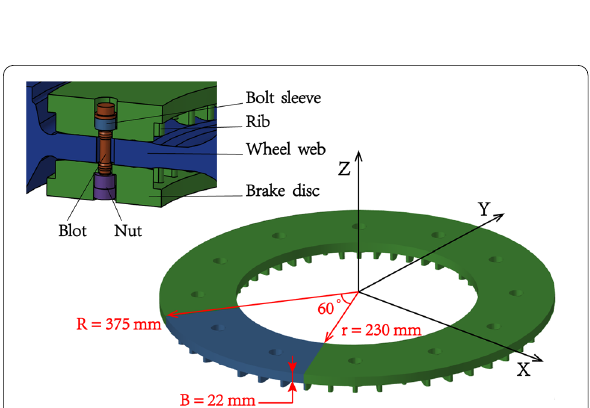
Figure 2 Geometric model of wheel-mounted brake